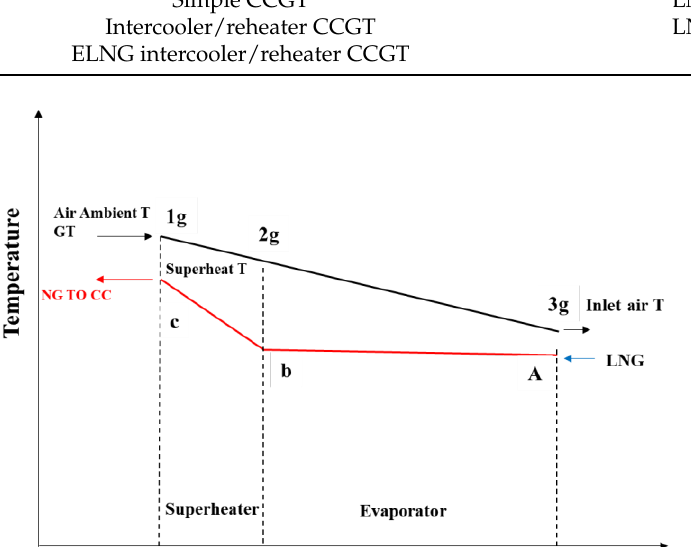
Figure 2. Heat balance in heat exchanger between the inlet air and LNG. 1g: inlet air mass flow temperature to heat exchanger; 2g: outlet air mass flow temperature from superheater stagnation to evaporator; 3g: outlet air mass flow temperature from heat exchanger to gas turbine; A: inlet LNG mass flow temperature to heat exchanger; b: outlet LNG mass flow temperature evaporator stagnation to superheater; c: outlet NG mass flow temperature from heat exchanger to combustion chamber gas